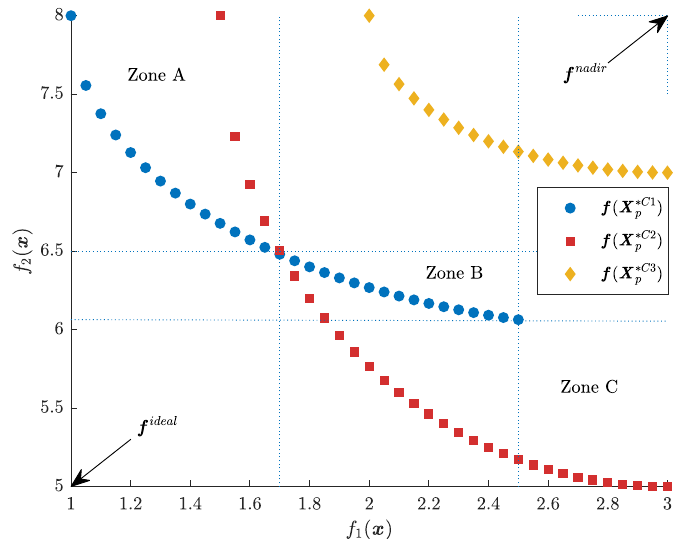
Figure 5. Three design concepts in a bi-objective optimisation problem. Example of comparison in the objective